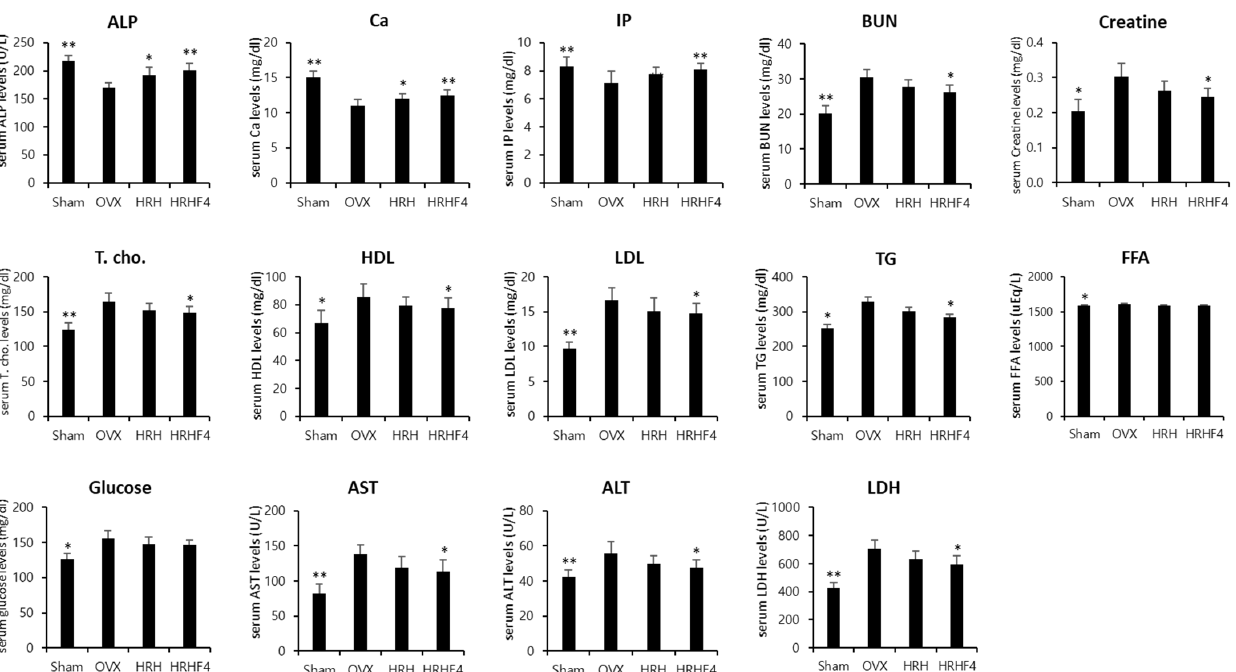
Figure 6. Serum biochemistry analysis of each mouse group. Values are expressed mean ± standard deviation ( n = 10). Two different types and doses of H. rhamnoides extracts were orally administered once a day for the next 84 days from the time of 84 days of osteoporosis induction after OVX surgery. * denotes p < 0.05, ** denotes p < 0.01 vs. OVX control, determined by the least significant difference test. OVX, bilateral ovariectomy; HRH, Hexane-soluble fraction from ethanol extract of H. rhamnoides fruits; HRHF4, Hexane-soluble fraction number 4 from ethanol extract of H. rhamnoides fruits; ALP, alkaline phosphatase; Ca, calcium; IP, inorganic phosphorus; BUN, blood urea nitrogen; HDL, high density lipoprotein cholesterol; LDL, low density lipoprotein cholesterol; TG, triglyceride; FFA, free fatty acid; AST, Aspartate Aminotransferase; ALT, alanine aminotransferase; LDH, lactate dehydrogenase.